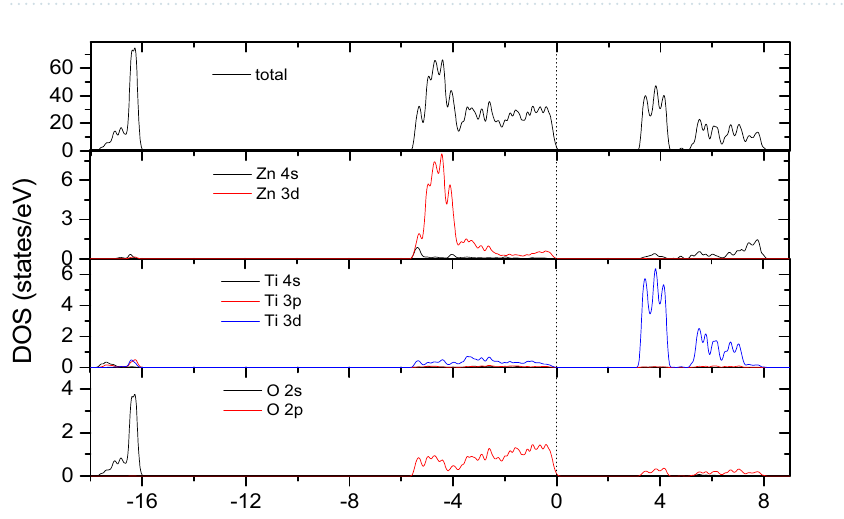
Figure 4. The band structures of LiNbO 3 -type ZnTiO 3 along the high symmetry directions in the Brillouin zone based on HSE06.